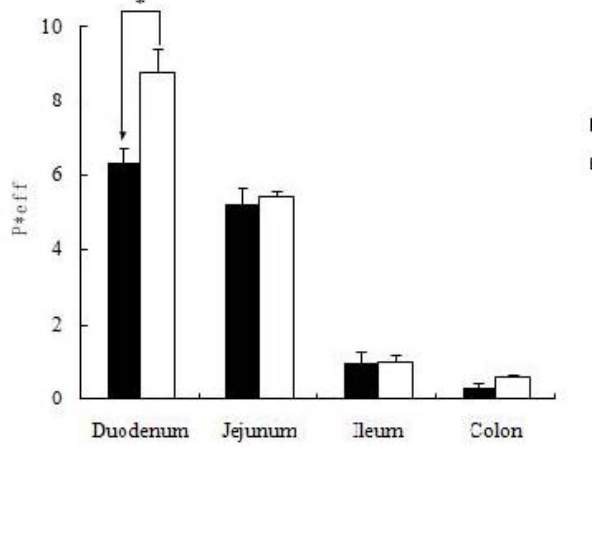
Figure 6. Comparison of permeability coefficient between four different intestinal segments. Data are expressed as mean ± S.D. (n = 4). The statistically significant differences are shown by the asterisk symbol, * p < 0.05 ( a : 20 μ M icariin + DOC, b : 20 μ M icariin + DOC + suet